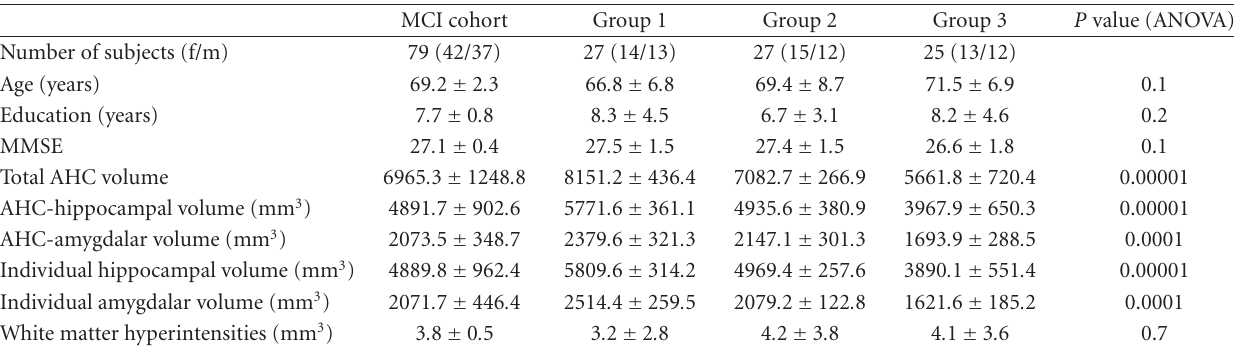
Table 3: Mean values ± standard deviation of sociodemographic characteristics, MMSE scores, white matter hyperintensities, and hippocampal and amygdalar volume measurements. Hippocampal and amygdalar volumes refer to the whole amygdalohippocampal complex (AHC) and are singularly considered (individual). The t -test refers to AHC versus individual volume in each